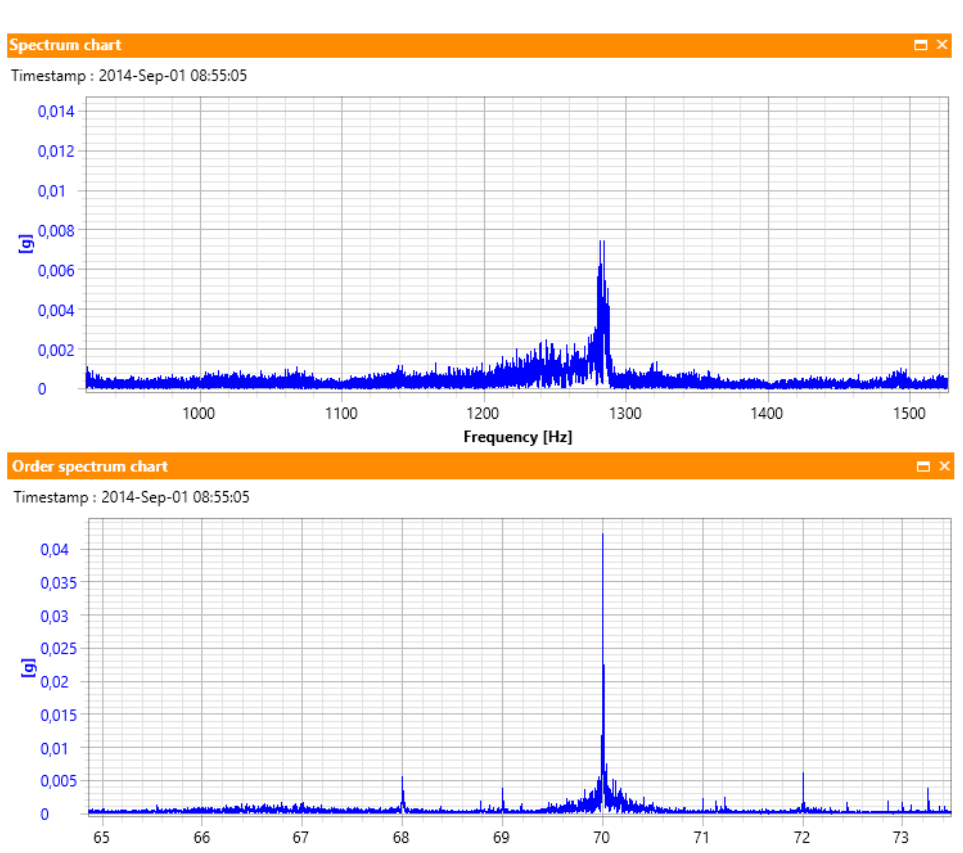
Figure 5. Demonstration of resampling ability to reduce spectral smearing.